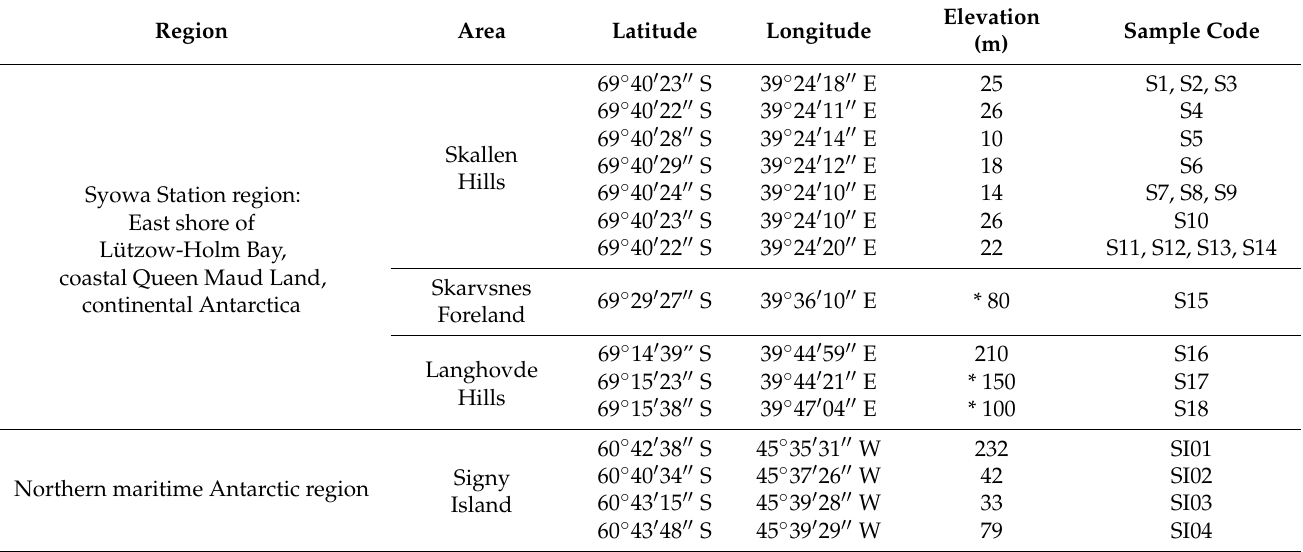
Table 1. Sampling sites of rock tripe lichens along the east shore of Lützow-Holm Bay, coastal Queen Maud Land, continental Antarctica and Signy Island, maritime Antarctica. Geographical coordinates and elevations were determined with GPSMAP62S and GPSMAP76S (Garmin, Olathe, Kansas, USA), except elevations indicated with asterisks, which were inferred from topographic